Question: Describe this figure in one sentence.
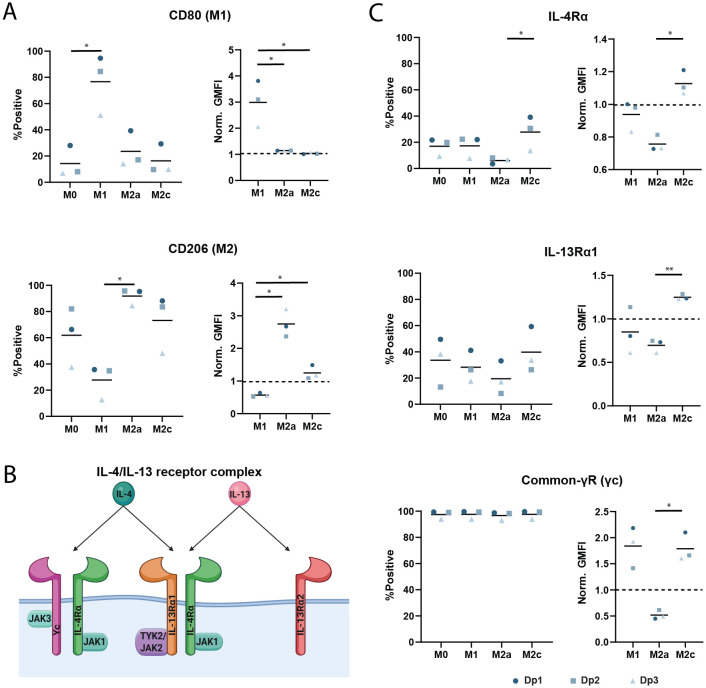
Answer: Macrophage polarization confirmation and interleukin-4 (IL-4)/IL-13 receptor complex expression measurement. (A) Polarization status of macrophages before initiating fusion (Day 0) was determined using cluster of differentiation 80 (CD80; M1) and CD206 (M2a). (B) Schematic of IL-4/IL-13 receptor complex; adapted from Nguyen et al., 2020 ( 53 ). Created in BioRender. Conner, T. (2026) https://BioRender.com/4h8j8pa . (C) Flow cytometry measurement of the three functionally active units of the IL-4/IL-13 receptor complex. Flow cytometry data shows the percentage of cells positive for the tested proteins and the geometric mean fluorescence intensity (GMFI) normalized to M0, for 3 donor pools (Dp1-3; n=3 biological replicates).